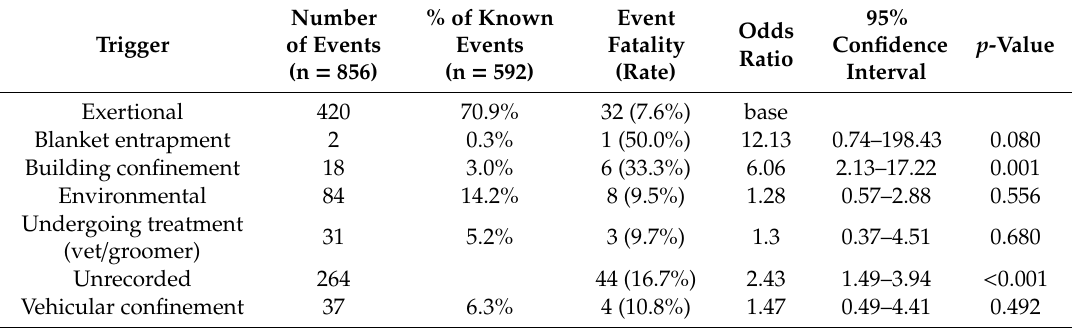
Table 2. Descriptive and binary logistic regression results for triggers as risk factors for heat-related illness associated fatality in dogs a ff ected between 2016–2018, under primary veterinary care in the VetCompass programme in the UK during